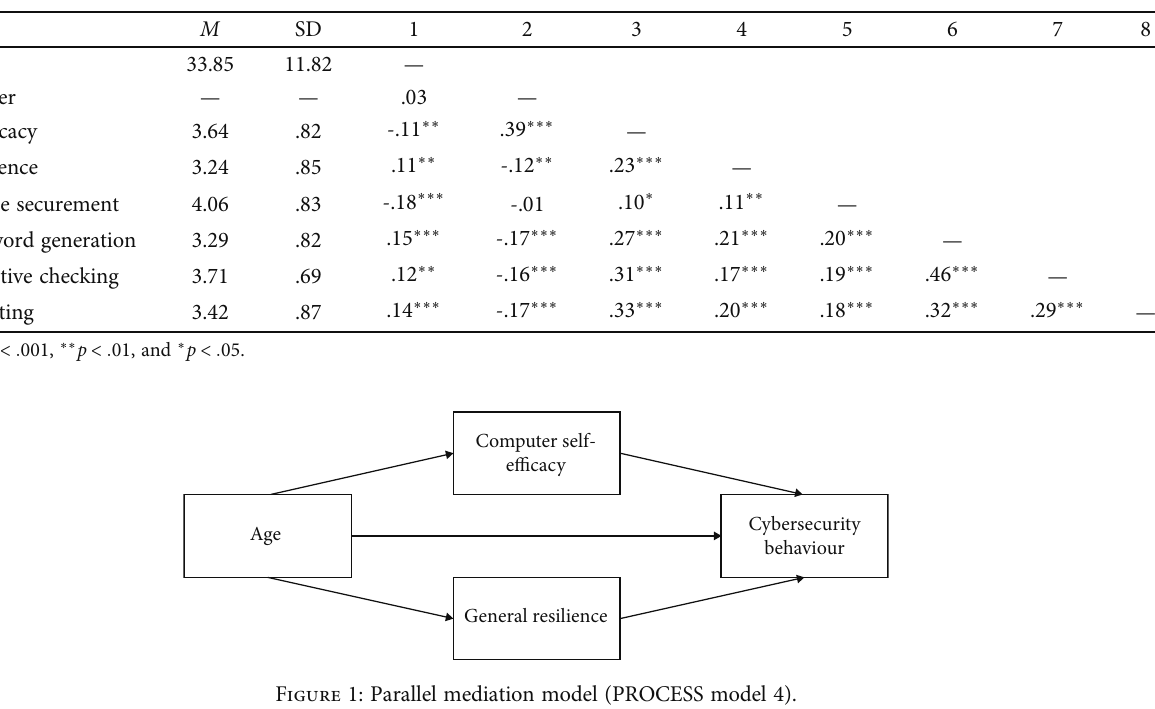
Table 3: Bivariate correlations for each of the variables.